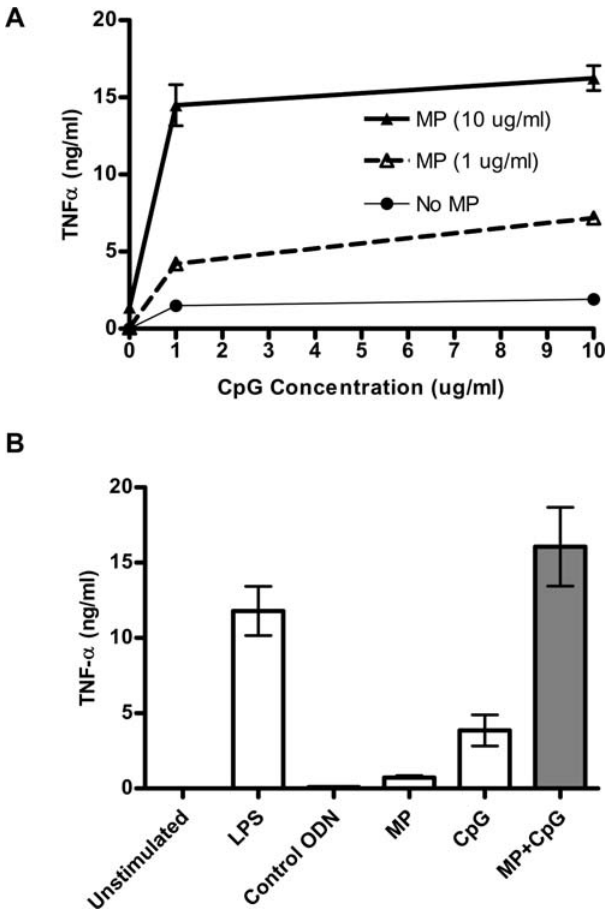
Figure 1. MP synergizes with CpG to stimulate cDCs to produce TNF- a . (A) cDCs were stimulated with CpG ODN 1826 (0, 1, or 10 m g/ ml) and/or MP (0, 1, or 10 m g/ml). Supernatants were collected 24 hours later and TNF- a concentrations determined by ELISA. Data are means 6 SEM of a representative experiment performed in singlicate. A second experiment yielded similar results. (B) MP + CpG synergize to produce more TNF- a than MP or CpG alone. Data represent mean- s 6 SEM of 6 independent experiments, each performed in singlicate. p , 0.001 comparing MP alone or CpG alone with MP + CpG by one way ANOVA with Tukey’s multiple comparison